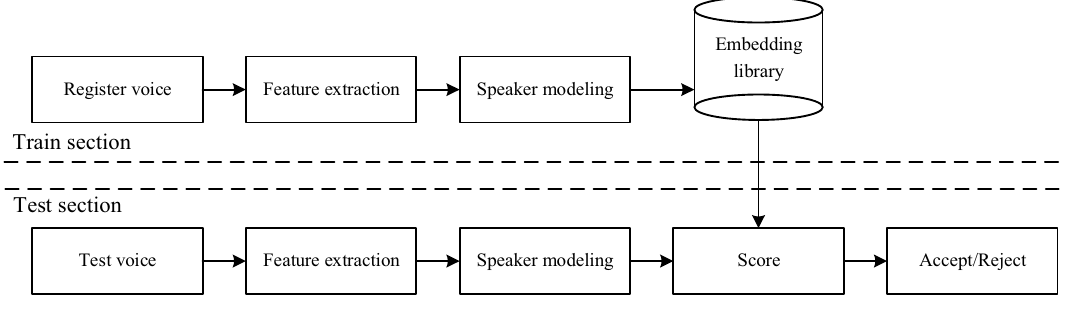
Figure 1. The framework of speaker verification system based on speaker